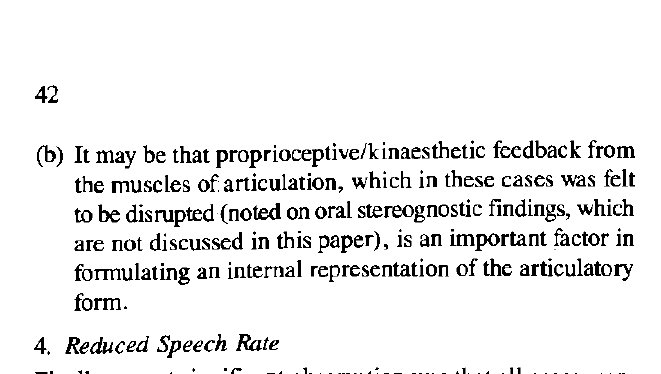
Figure 2 Case 2: F.T. 's CT scan showing cerebral infarcts in the (L) parieto-frontal region involving Broca's area and in the (R) parieto-occipital region.